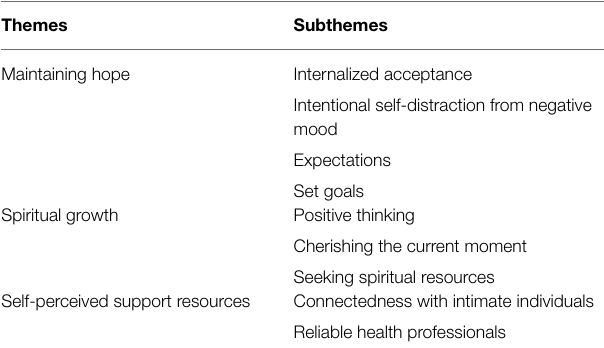
TABLE 2 | Synthesized themes and subthemes of Chinese MBC women’s coping strategies.